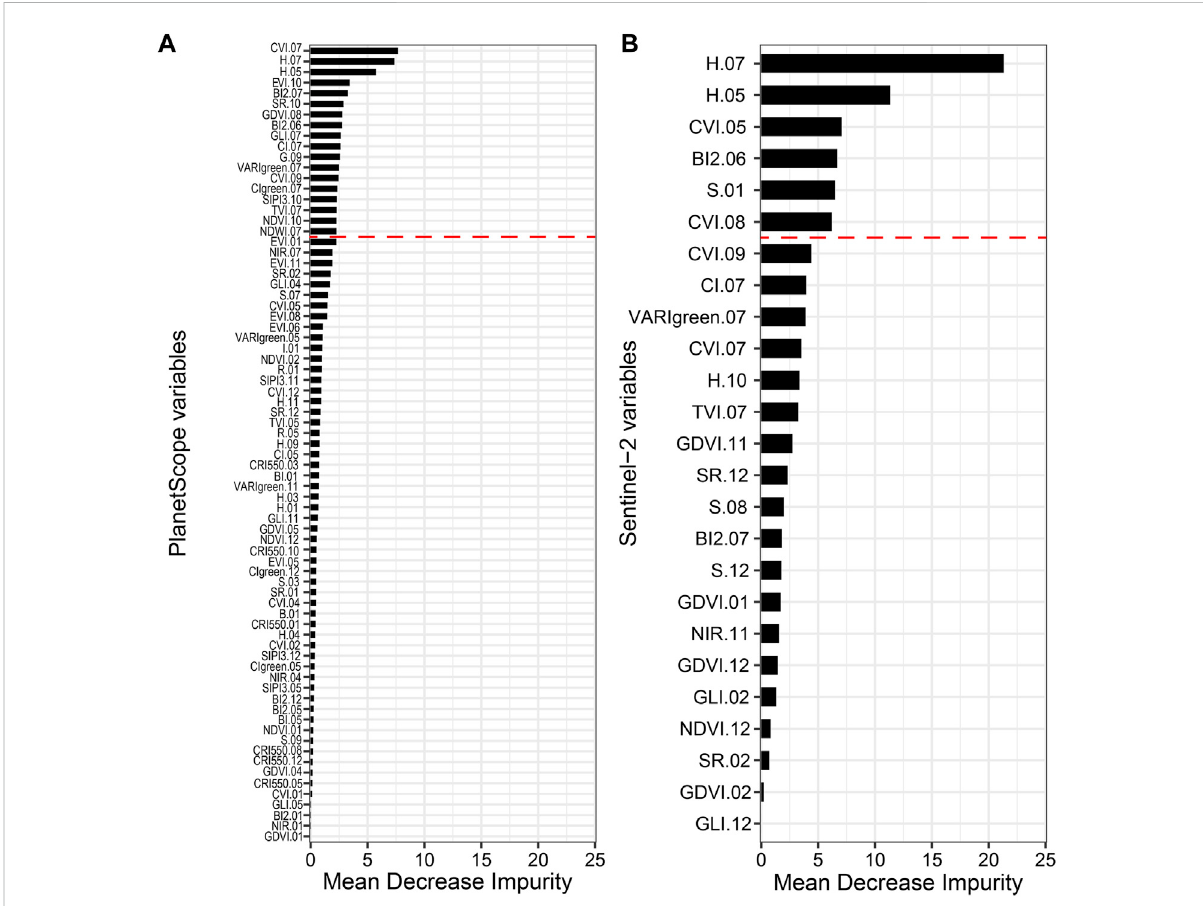
FIGURE 5 Relative importance of RS spectral variables in percentage (%) calculated using the mean decrease impurity for (A) PlanetScope (75 variables) and (B) Sentinel-2 (25 variables) RF models. Spectral variables are reported in Table 1. Red dashed lines indicate the 60% of cumulated MDI